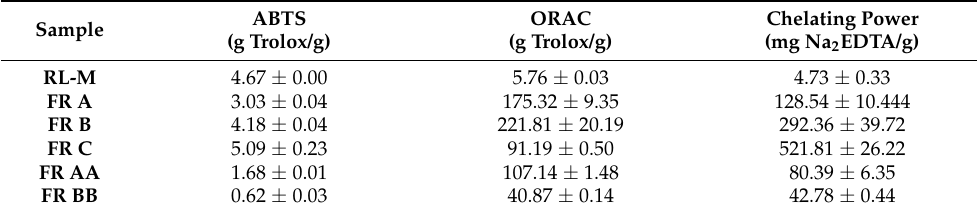
Table 4. Antioxidant activity and metal chelating power of Rhododendron luteum Sweet leaf samples. The results of the radical scavenging assay with ABTS and ORAC are expressed as g of Trolox/g of dry extract (DE). The results of metal chelating activity are expressed as mg of Na 2 EDTA/g DE. Abbreviations as in Table